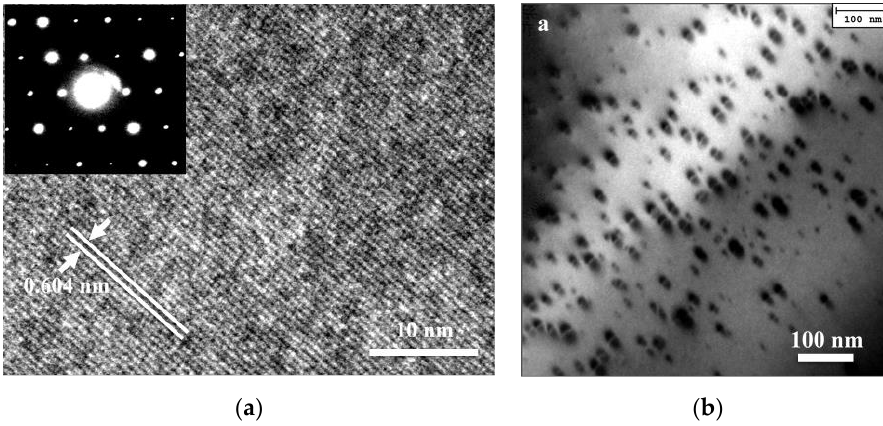
Figure 10. TEM images. ( a ) The lattice spacing of the planes is clearly visible and corresponds to the (200) lattice planes of the monoclinic crystal. The inset is the electron diffraction pattern taken in the [010] axis orientation. ( b ) Area of the sample with a high density of coherent lattice defects.